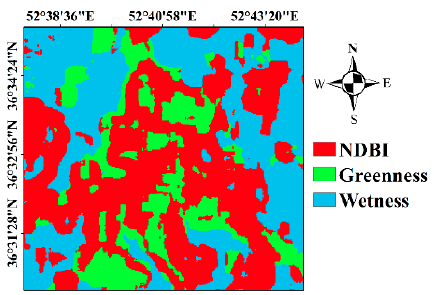
Figure 11. Spatial distribution of the most influential biophysical parameters on LST variations.